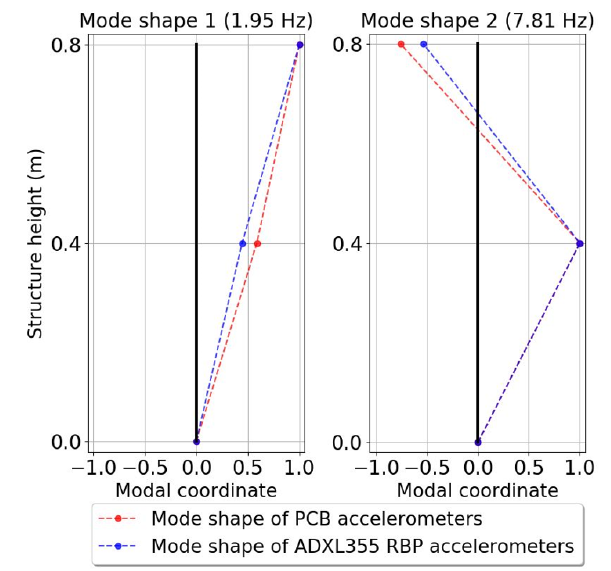
Figure 20. Mode shapes estimated by the monitoring systems.